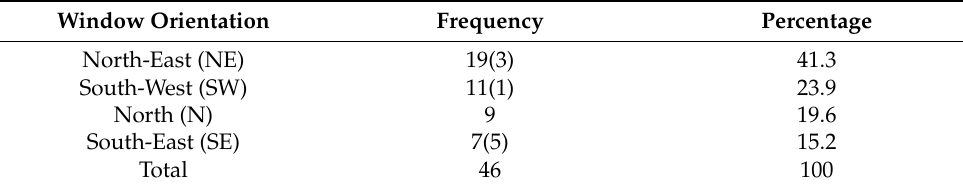
Table 7. Number of rooms based on the location of the windows—within parenthesis: the rooms with two